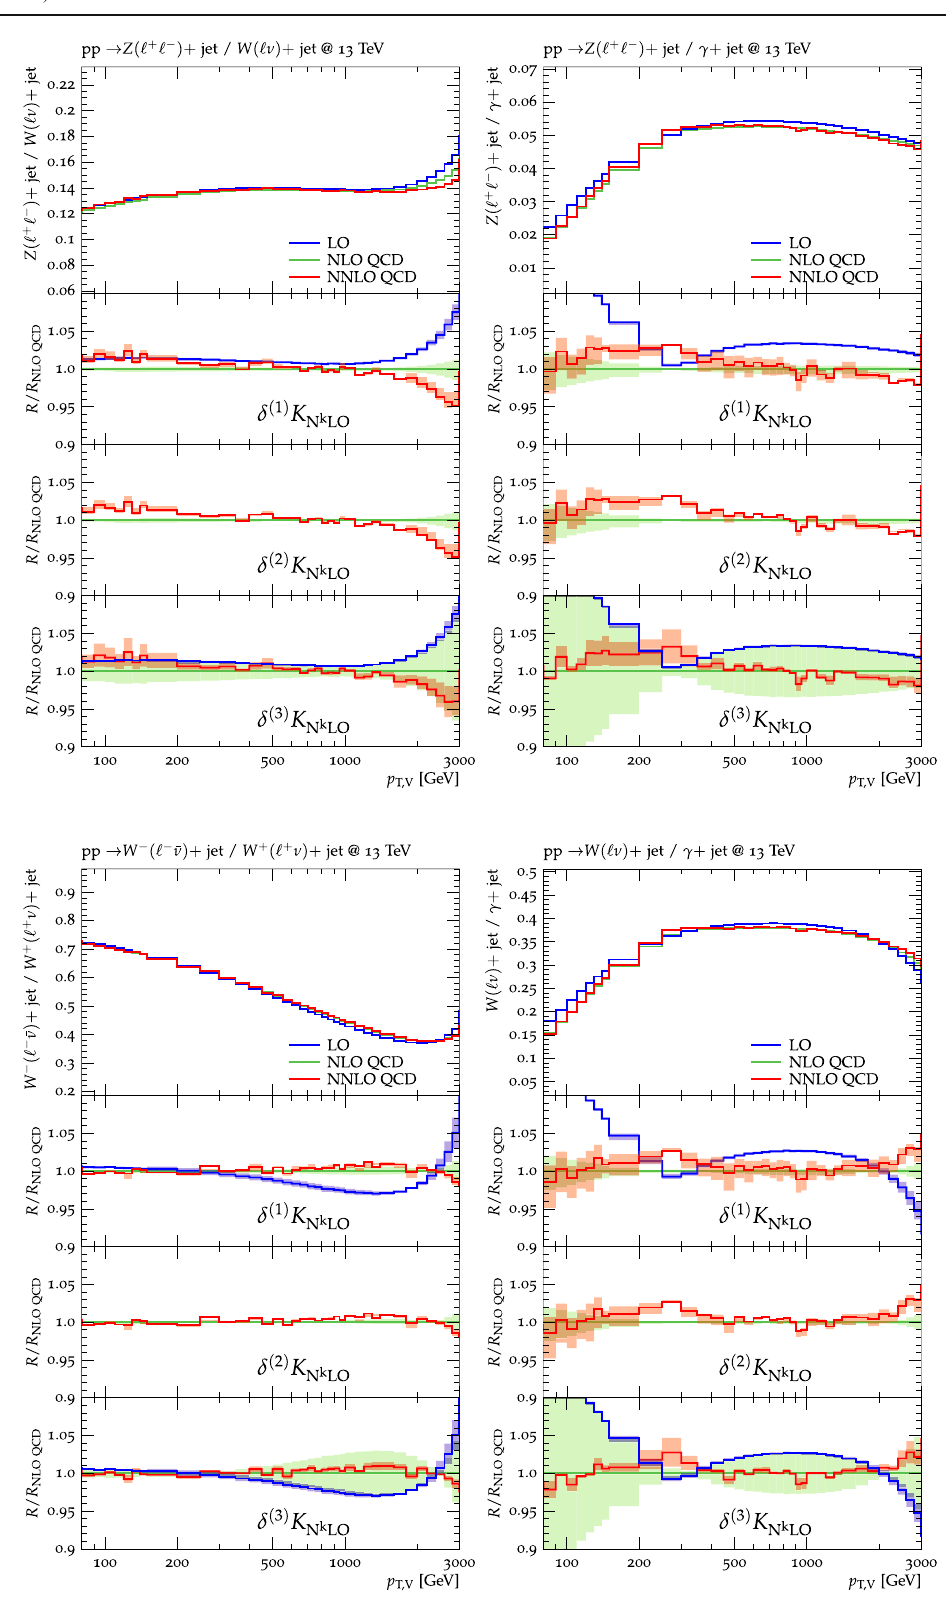
Fig. 19 Ratiosof p T -distributionsforvarious pp → V + jetprocessesatLOandNLOQCD.Therelatedscaleuncertainties(33),shapeuncertainties (35) and process-correlation uncertainties (38) are correlated amongst all processes as discussed in Sect.